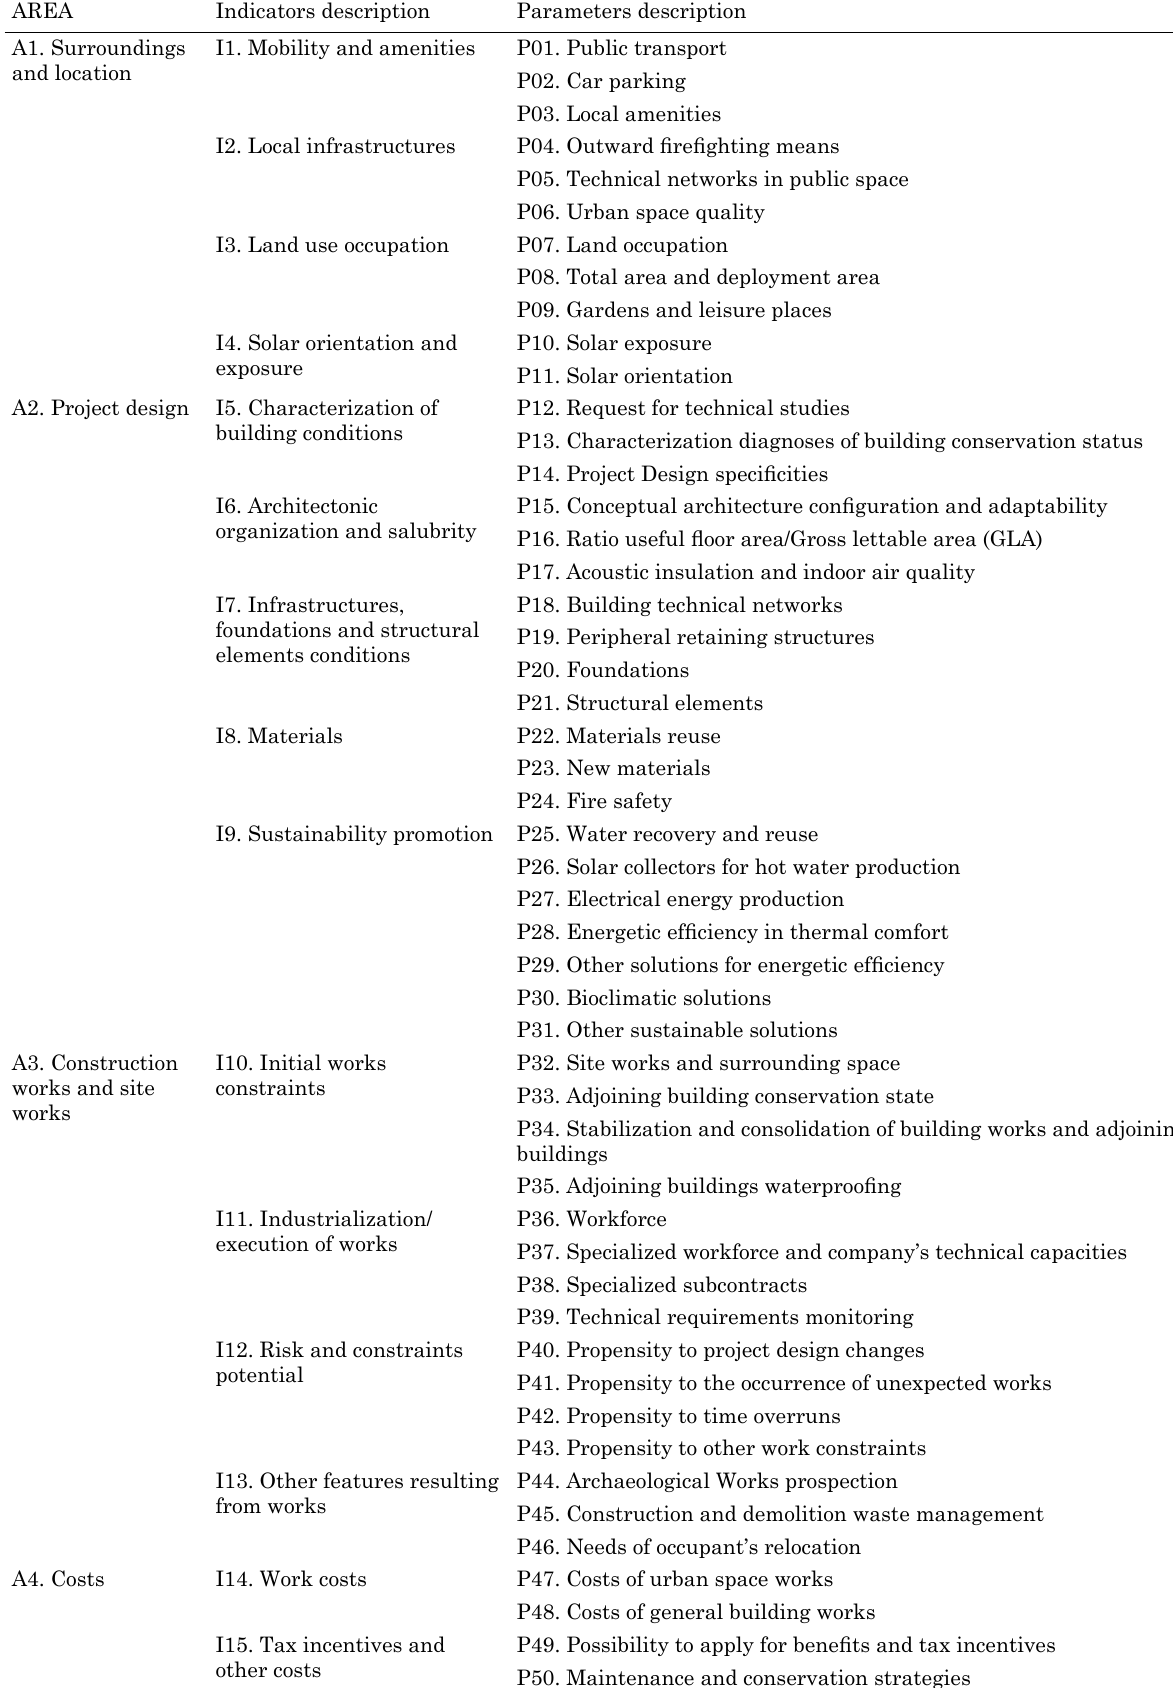
Table 2. Management system thematic areas, indicators and parameters